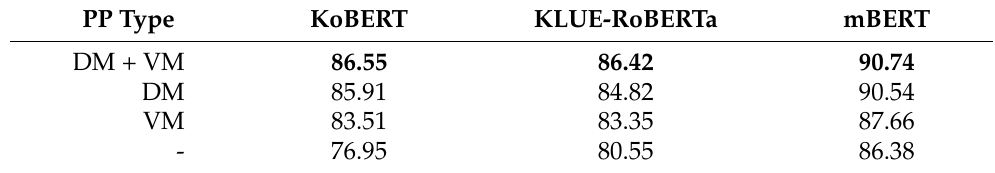
Table 5. Ablation Study on value-refiner. DM indicates the Database-Matching module, and VM is Value-Matching module. The number in the table is the result of joint goal accuracy